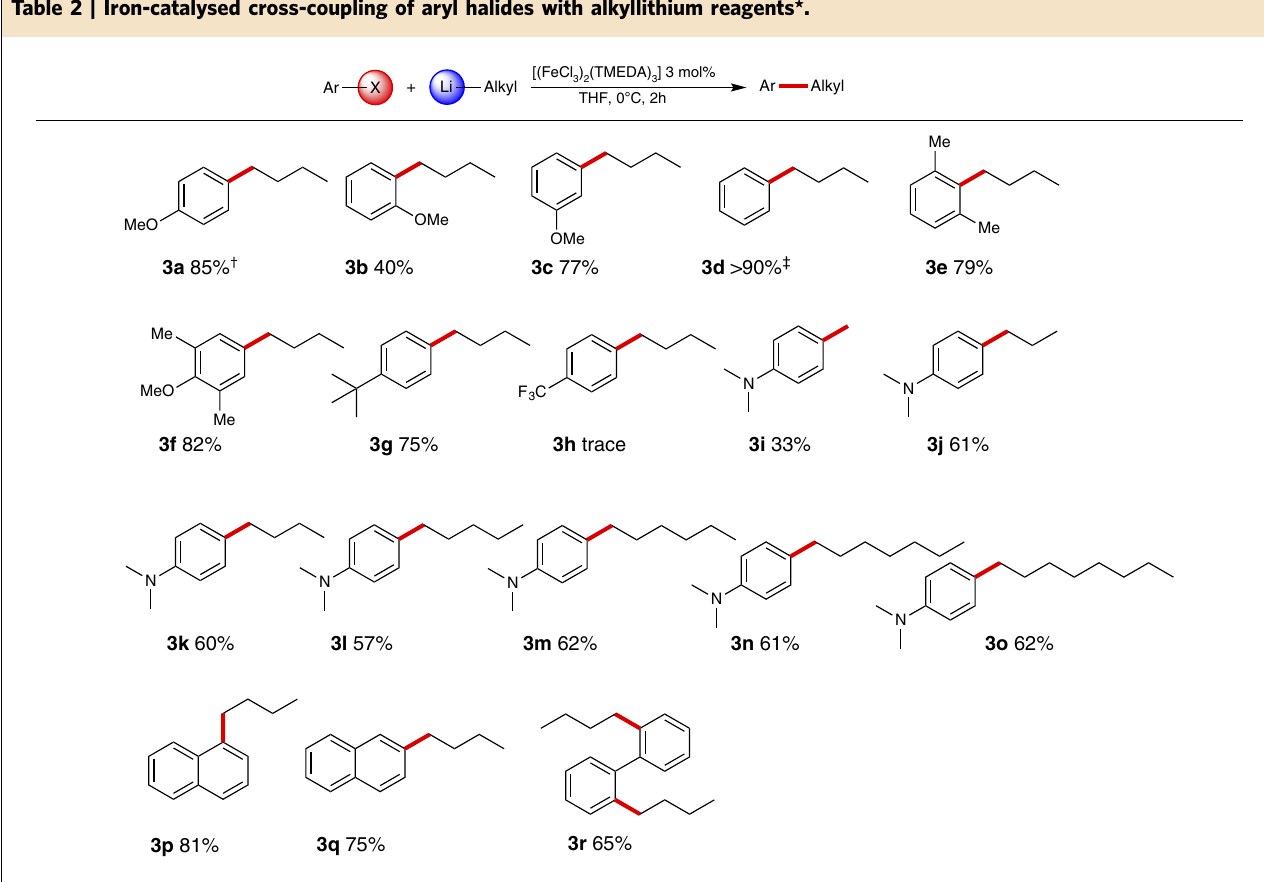
4-bromo- N,N -dimethylaniline (Table 2, 3i - 3o ). Polyaromatic compounds were found to undergo alkylation in moderate yields (Table 2, 3p - 3q ). In addition, a double alkylation product was obtained in 65% yield (Table 2, 3r ).